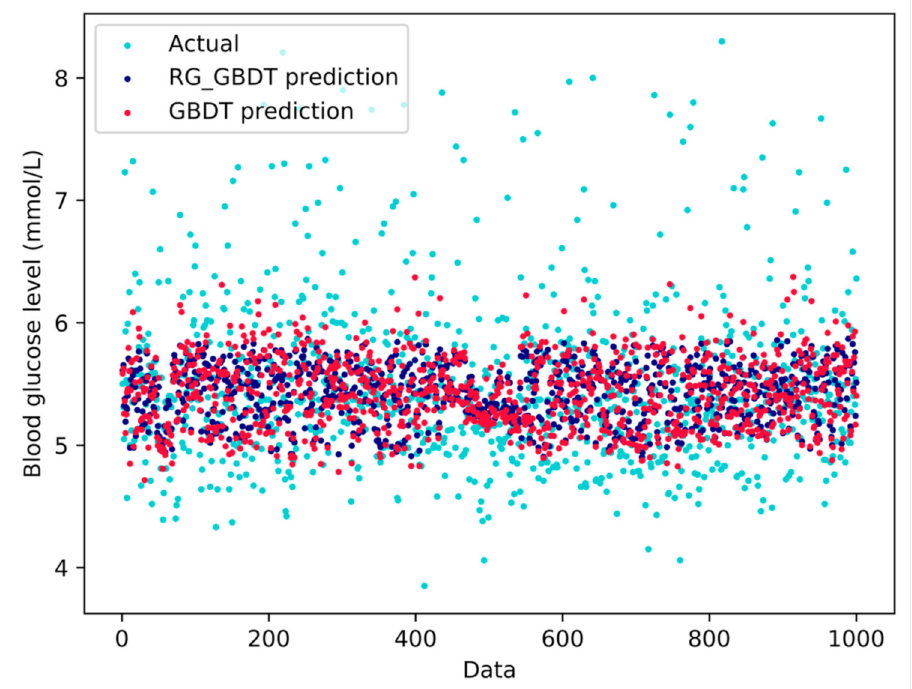
Figure 11. The scatter plot diagram of the actual and predicted blood glucose (fasting/pre-prandial) levels by the RG_GBDT and GBDT